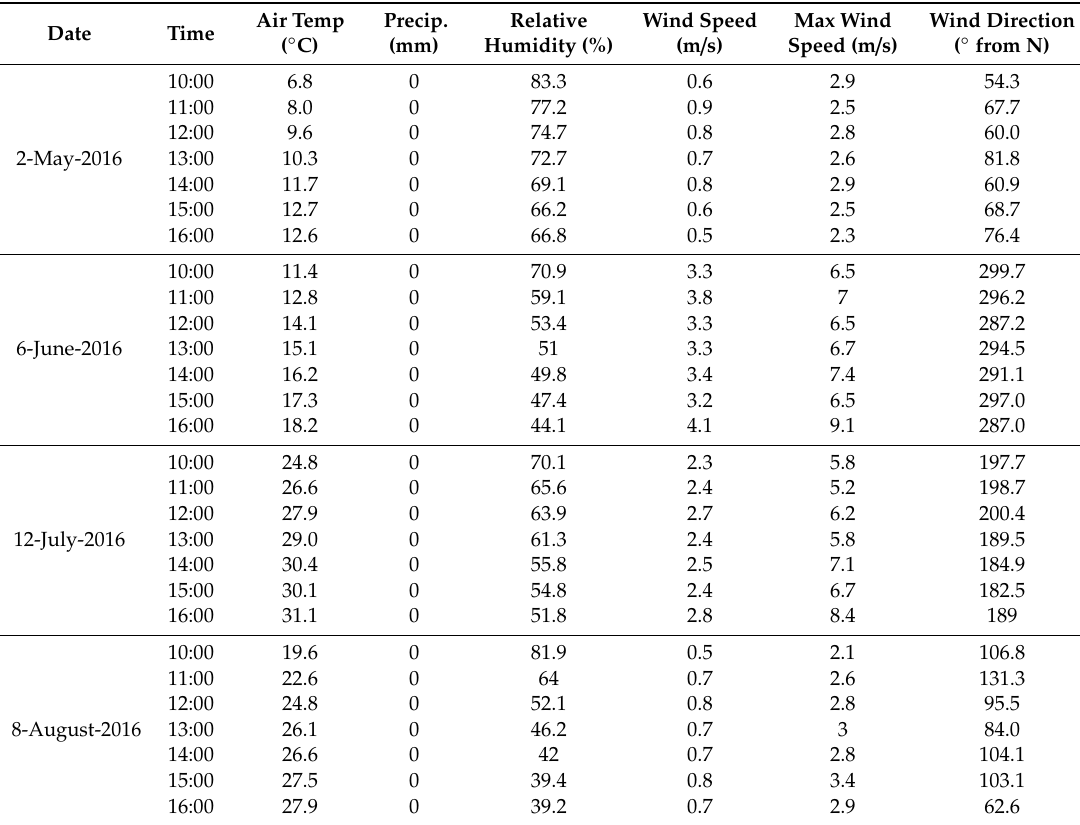
Table 1. Environmental weather data from Clarksville Research Station’s Enviro-weather station on spray evaluation days. Wind came from the E / NE in May, W / NW in June, S / SW in July, and E / SE in